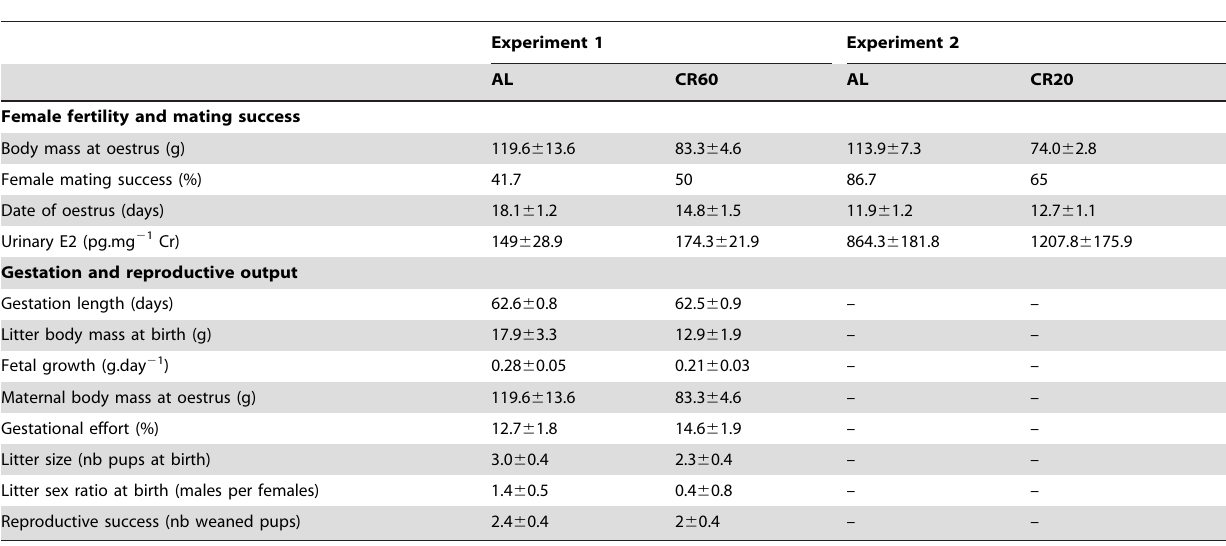
Table 2. Reproductive parameters of females fed ad libitum (AL) or exposed to either a 40% chronic caloric restriction (CR60) or a 80% acute caloric restriction